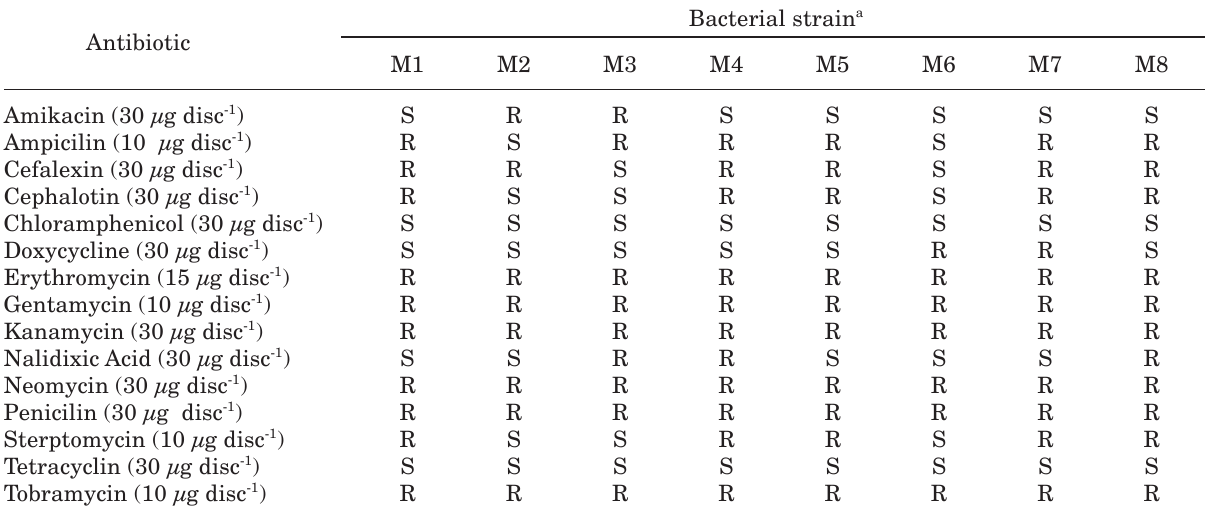
Bacterial strain